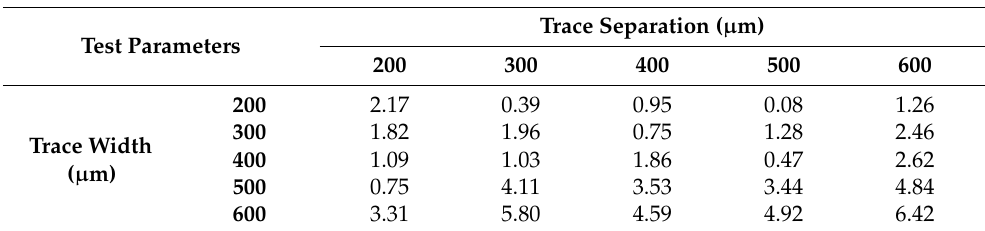
Table 4. The percentage error between the numerically calculated and measured inductances of elliptical planar inductors after using the proposed model for different combinations of trace separation ( S ) and trace width ( W ) while major-to-minor ratio ( R ) = 3 and number of turns ( N ) = 10. % Error in Calculated and Measured Inductances (Number of Turns ( N ) = 10, Major-to-Minor Ratio ( R ) = 3) Trace Separation ( μ m) Test Parameters